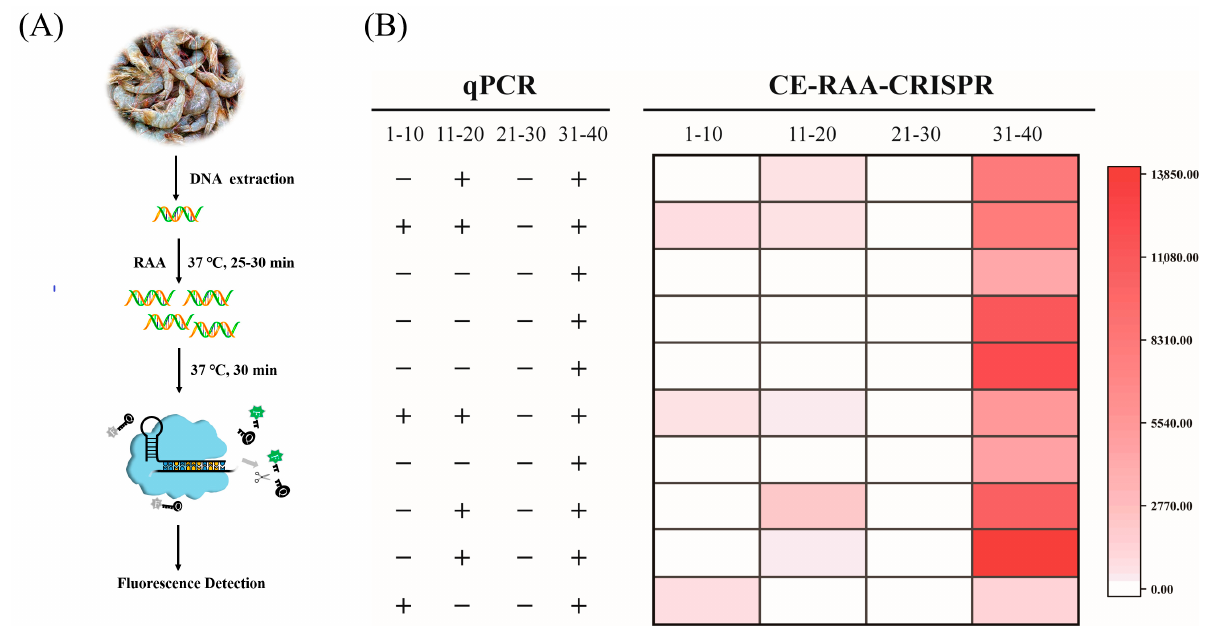
Figure 7. Evaluation of CE–RAA–CRISPR for the detection of V. parahaemolyticus in actual food samples. ( A ) Schematic illustration for the detection of V. parahaemolyticus in actual food samples using CE–RAA–CRISPR. ( B ) Detection of V. parahaemolyticus in 40 aquatic samples using the qPCR method (left) and CE–RAA–CRISPR assay (right).